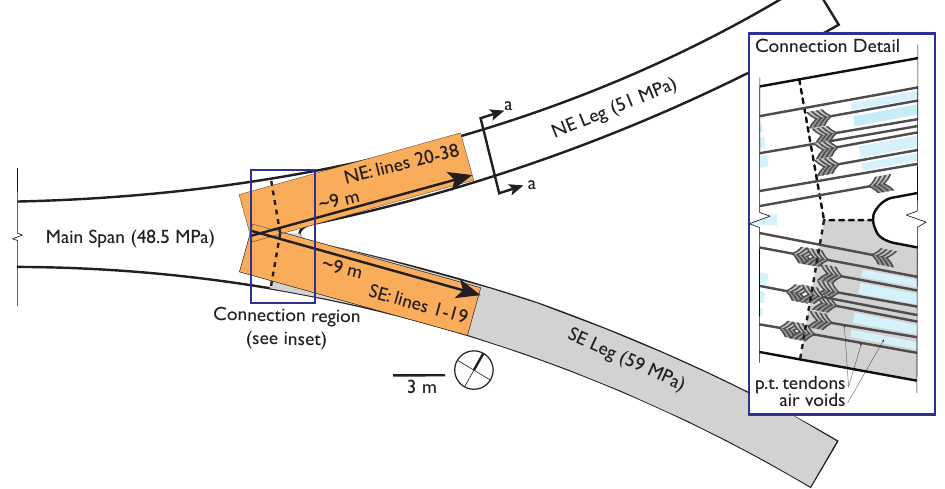
Figure 3. Plan view of scanned areas of Streicker Bridge with strength and detail of connection